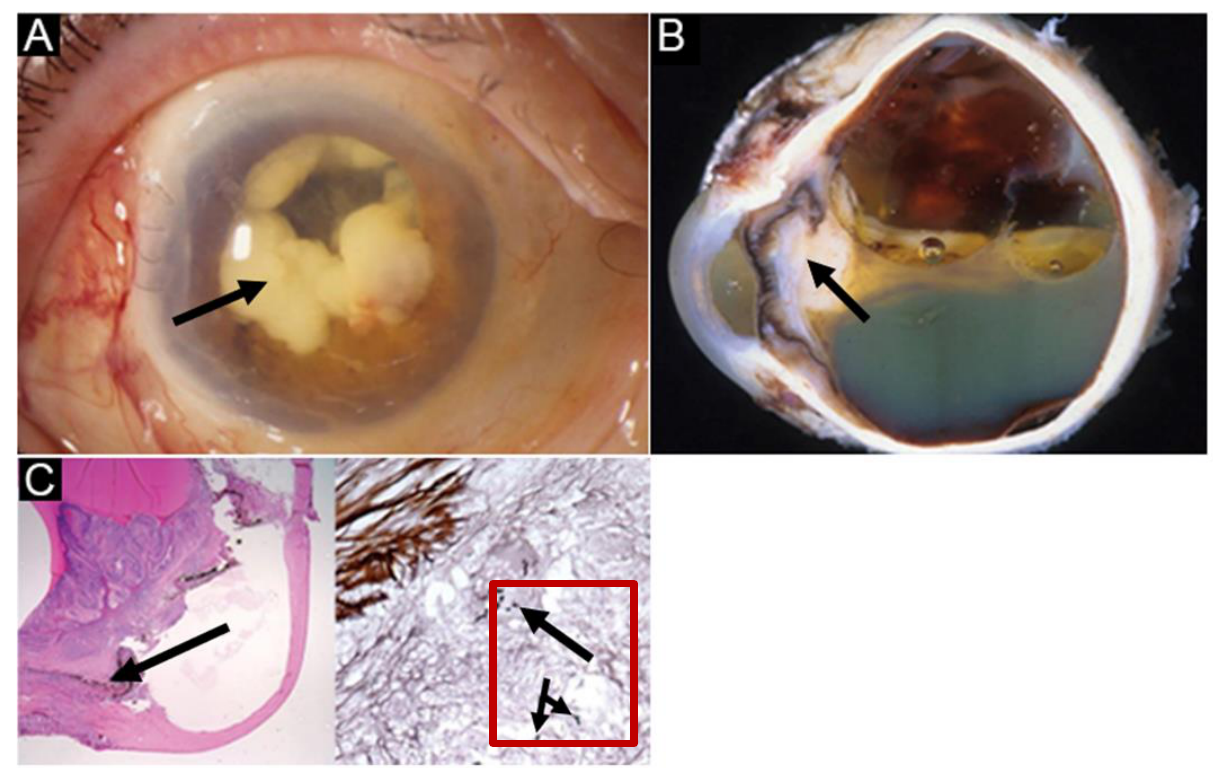
Figure 2. ( A ) An image of a 69-year-old woman’s infected eye 2 months post-cataract surgery. The eye illustrates extensive Aspergillus infiltration in the anterior chamber. Aspergillus endophthalmitis treatment includes multiple procedures: a pars plana vitrectomy, lens removal, and amphotericin B injections. Due to a poor response to mainstream treatment options, enucleation was performed as a last resort. ( B ) A cross-section image of the eye after enucleation. The voracity of the infection is apparent with a clear detachment of the retina. The intense creamy white plaque around the iris displays the virulent spread of Aspergillus . ( C ) An H&E-stained histopathological image of the infected eye with higher magnification is shown on the right. The image on the right reveals individual Aspergillus hyphae formation, shown in the red box with corresponding arrows that occurs during infection spread. Image courtesy: Haddock et al. [62] .